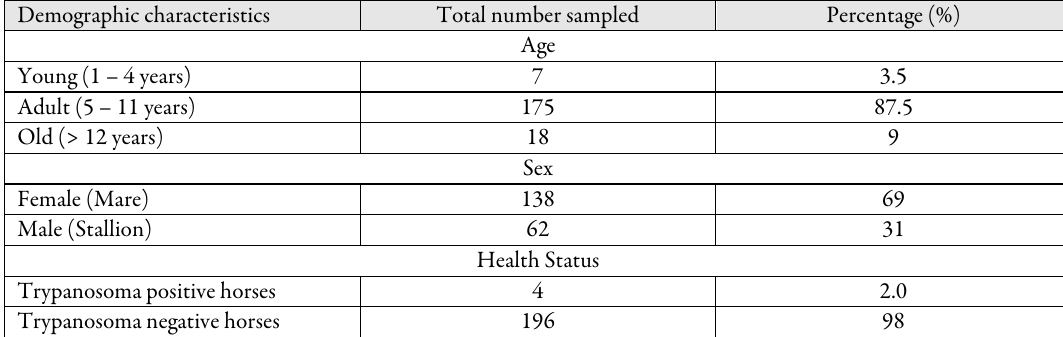
Table 2. Distribution of Trade horses sampled by their demographic